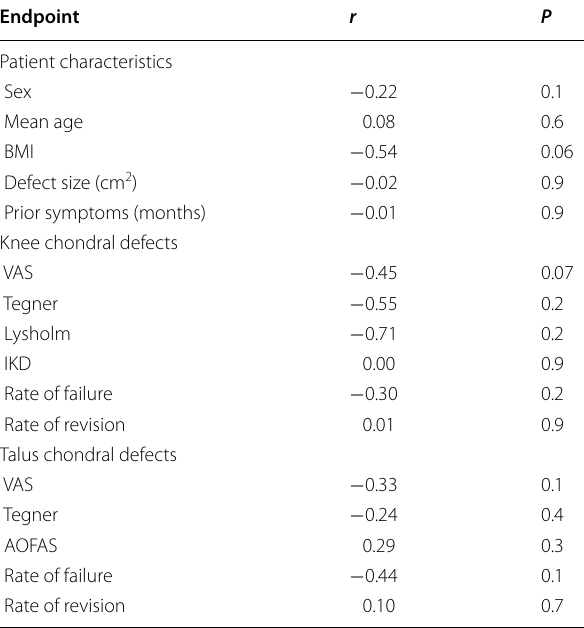
Table 2 Overall results of the